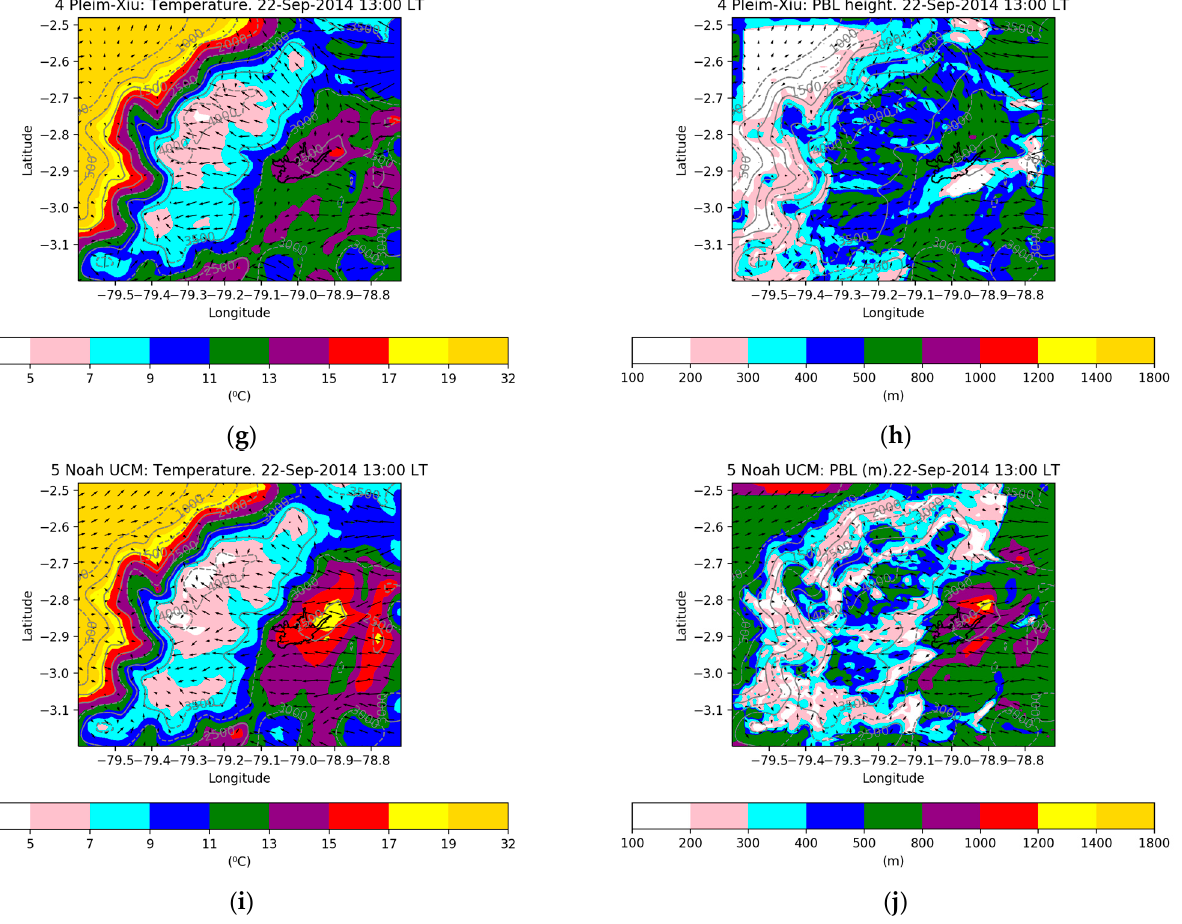
Figure 5. Modeled temperature and planetary boundary layer height on 22 September 2014 (13:00 LT): ( a , b ) 1 5-Layer; ( c , d ) 2 Noah; ( e , f ) 3 RUC; ( g , h ) 4 Pleim–Xiu; ( i , j ) 5 Noah UCM.